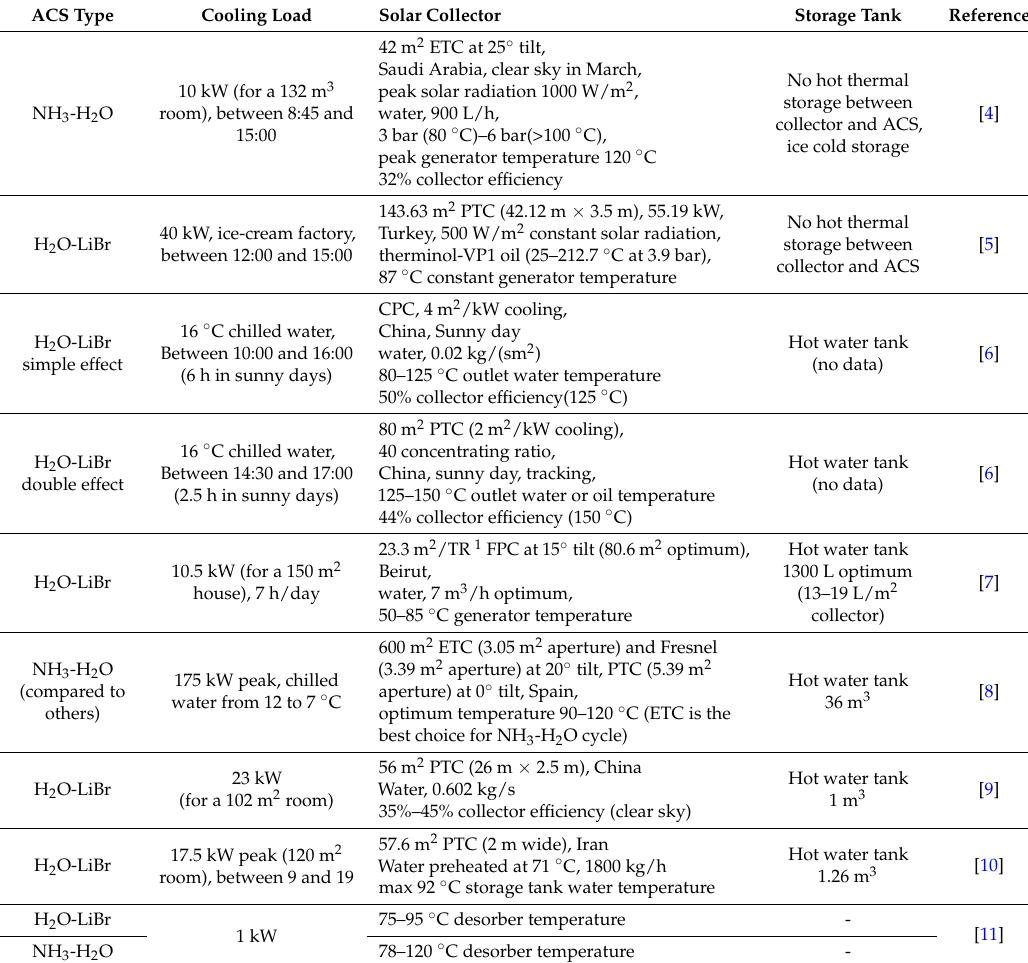
Table 1. Literature review